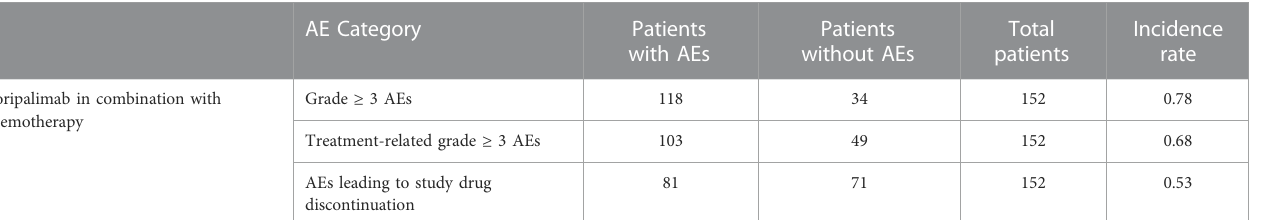
TABLE 3 Summary statistics for AE